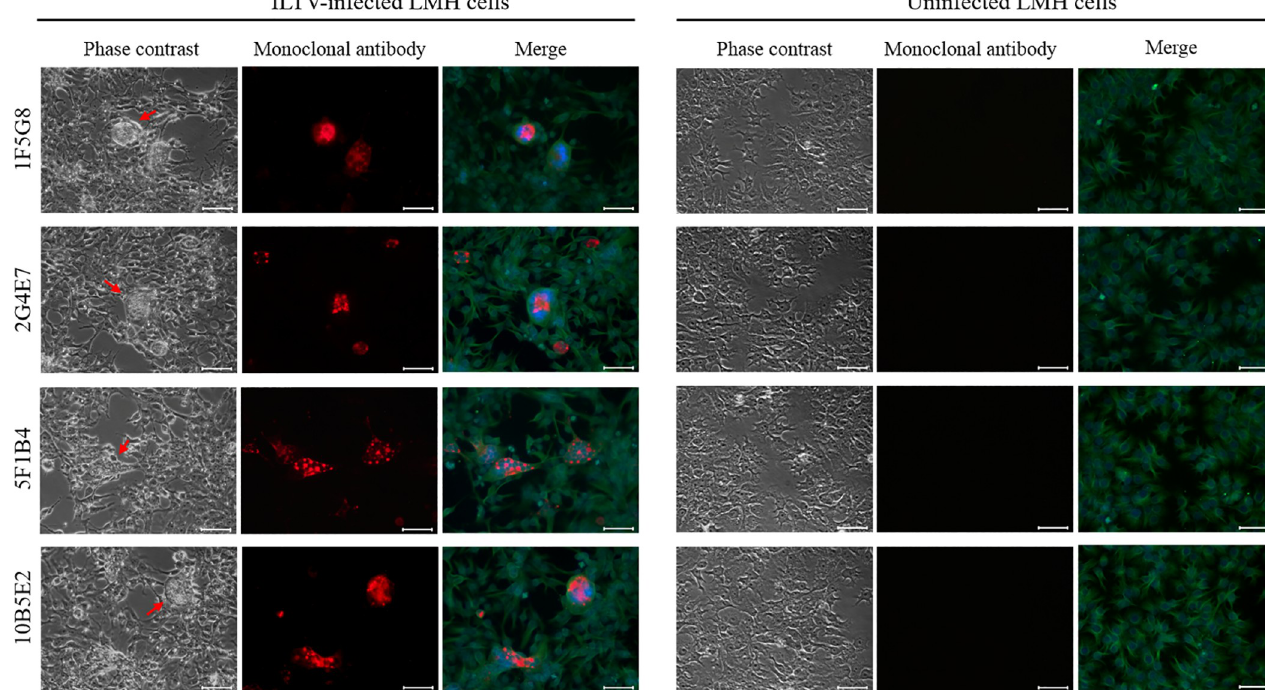
Fig 4. Recognition of gG by monoclonal antibodies in LMH cell cultures infected with the VFAR-043 strain. Immunofluorescence assays were carried out using each monoclonal and anti β -Tubulin III antibodies. Nuclear staining was performed with DAPI mounting solution. Green and blue fluorescence correspond to β -Tubulin III and nuclear staining, respectively. Uninfected LMH cells were used as negative controls. Red arrows show cytopathic effect zones. Scale bars: 50 μ m. Image magnification: 400x.